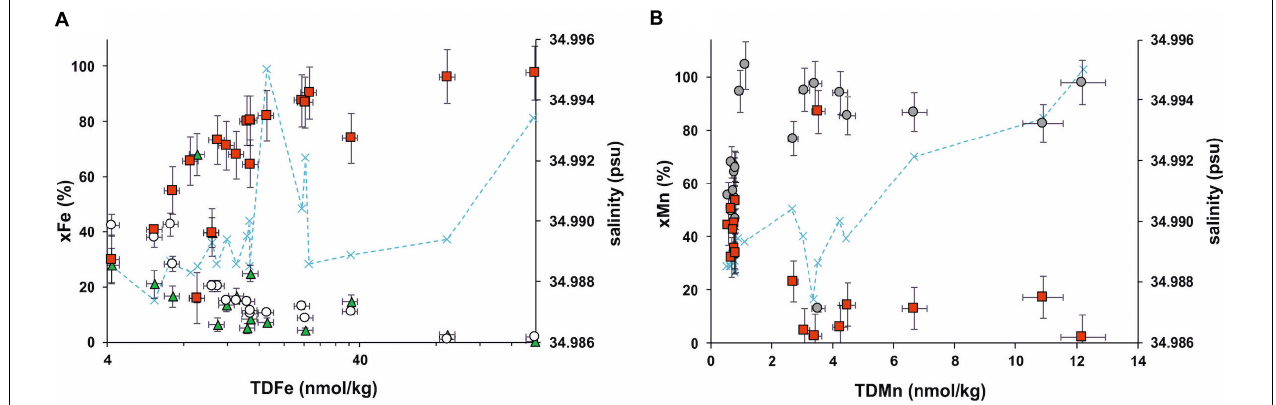
FIGURE 3 | Particulate Fe (red squares), cFe (green triangle), and sFe (white circle) percentage relative to TDFe (xFe) in the VDVF hydrothermal plume (A) . Particulate Mn (red squares), dMn (gray circles) percentage relative to TDMn (xMn) in the VDVF hydrothermal plume (B) . sMn is not shown as this is equal to dMn concentration for the vast majority of samples. Note the log scale on the TDFe axis (A) .